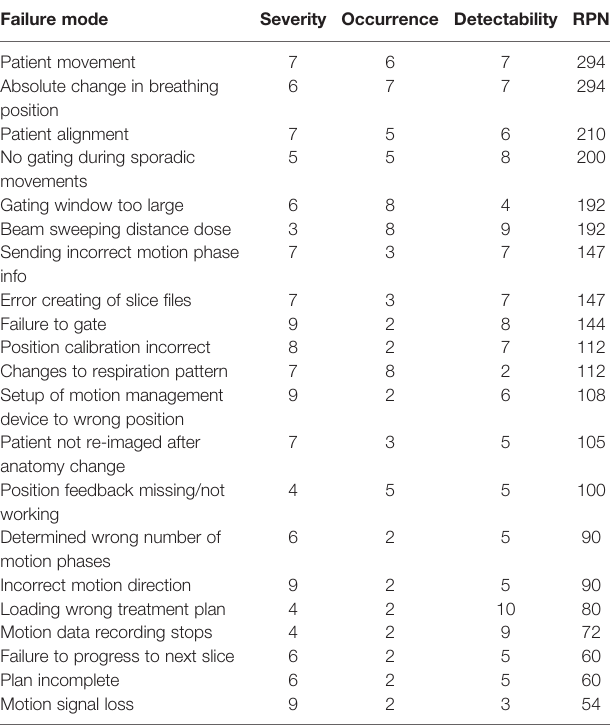
TABLE 3 | Summary of failure modes and effects analysis (FMEA) results for potential errors during patient therapy with motion-synchronized ion beams using a DDS with integrated motion compensation controls. Risk priority numbers (RPNs) of over 125 were considered high